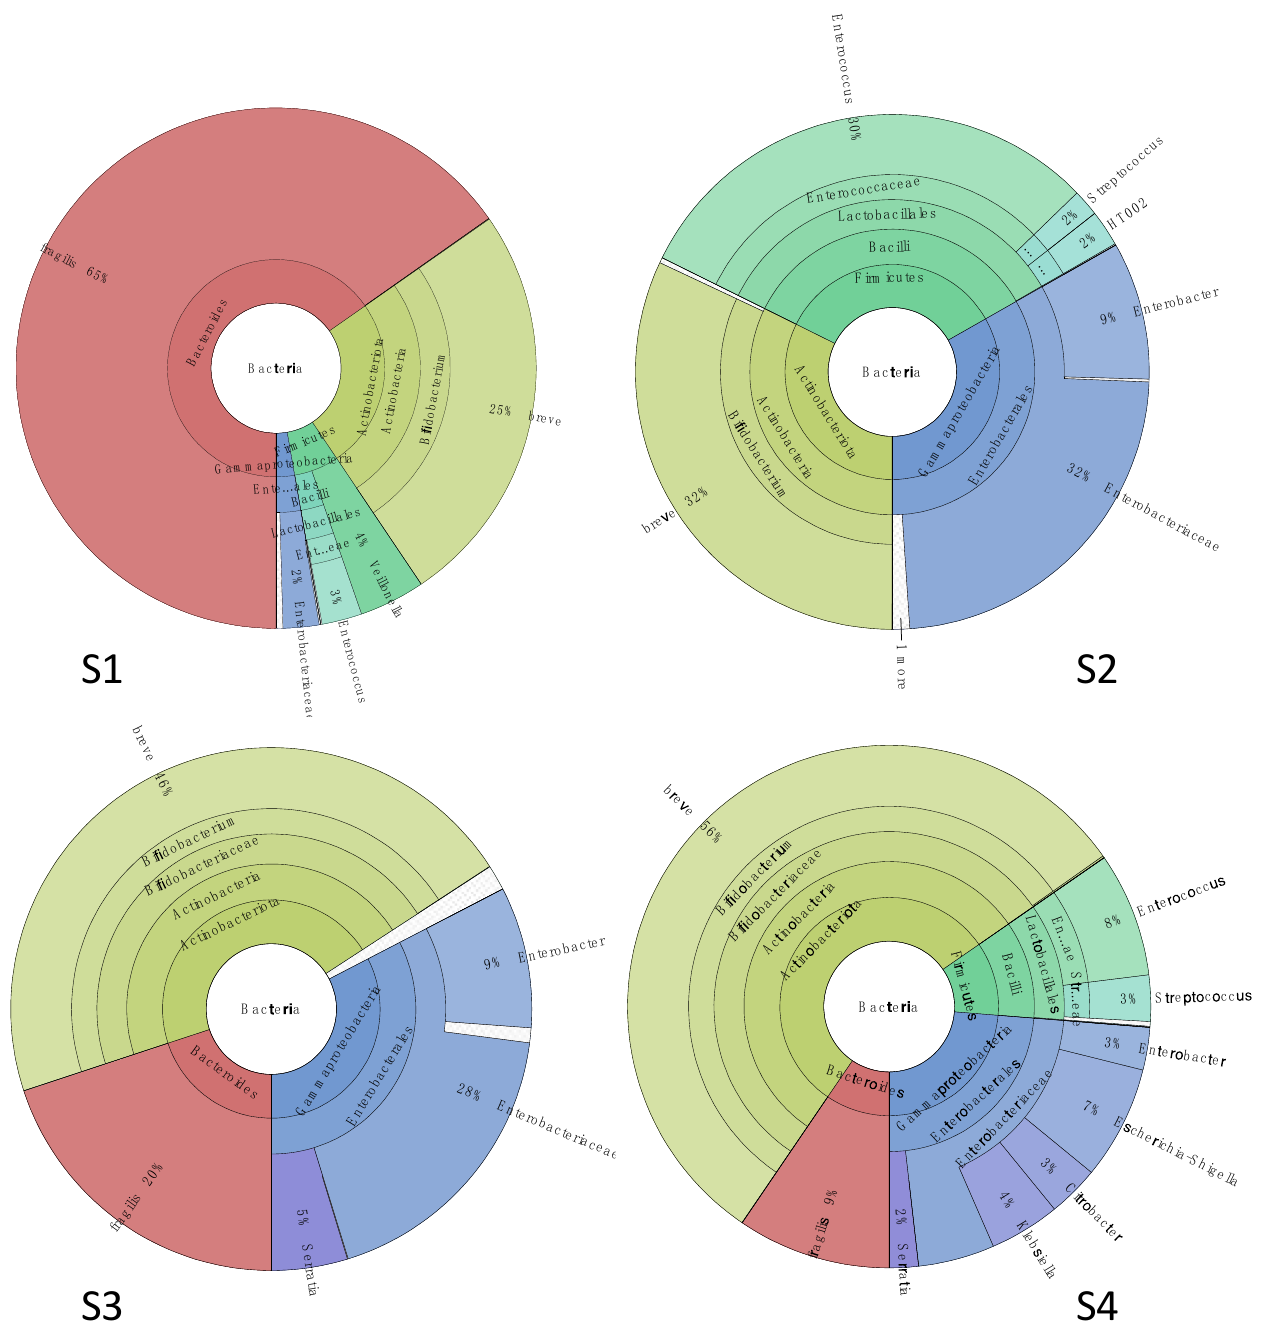
Figure 4. Microbiota structure assessed by metabarcoding analysis at first month of life. Sample ( S1 ) was collected before the antibiotic therapy; samples ( S2 – S4 ) were collected at 1, 10, and 15 days after the end of the treatment. A low coverage whole metagenome analysis (WMS) was carried out on samples S1 and S2 in order to explore the gut microbiome structure down to the species level (Supplementary Figure S4). Generally, data obtained via this sequencing strategy were consistent with the metabarcoding analysis, with only small changes in the relative abun- dances of the most represented